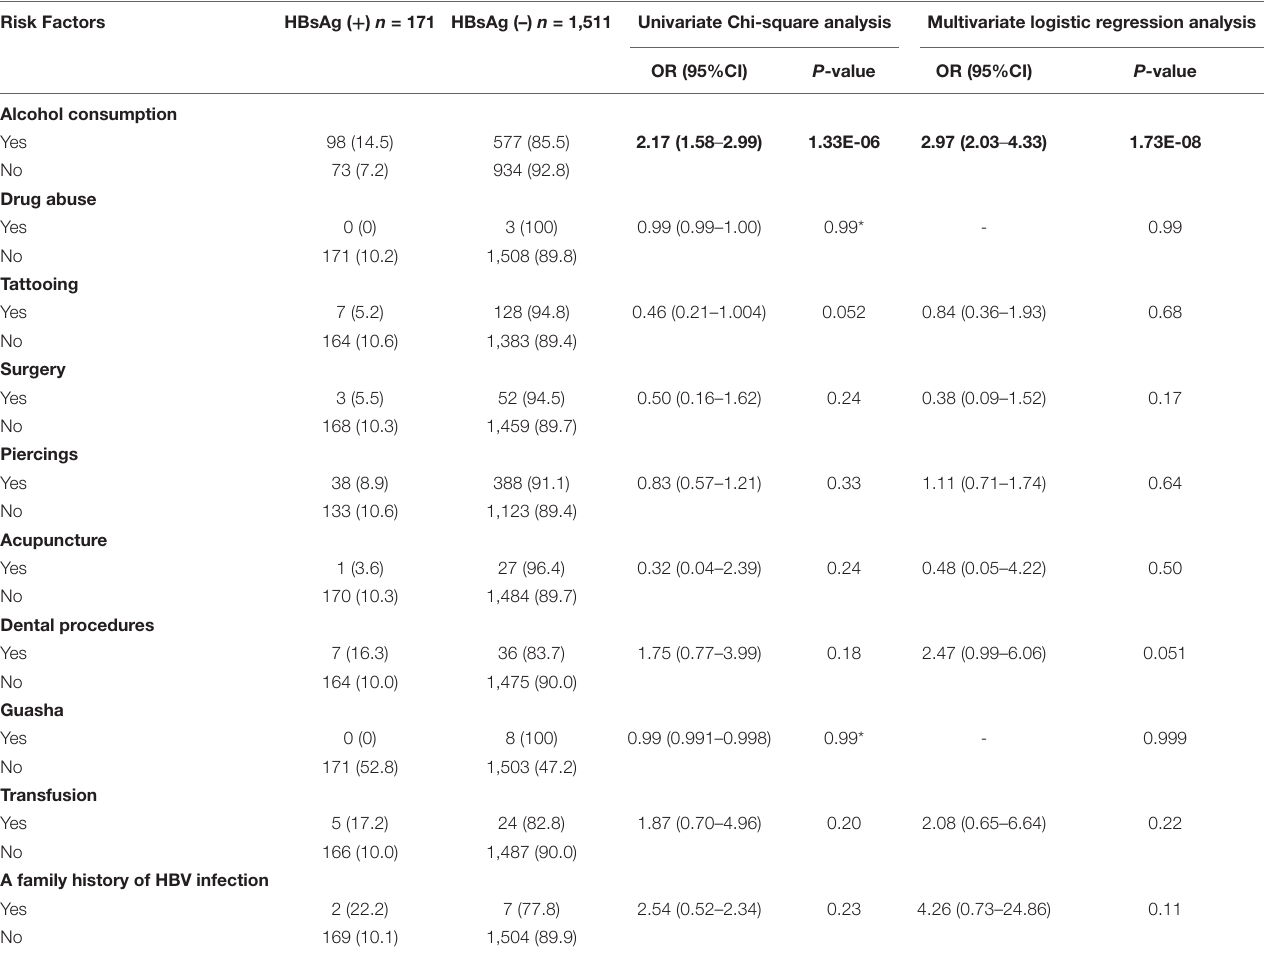
TABLE 3 | Risk factors for HBV infection. Risk